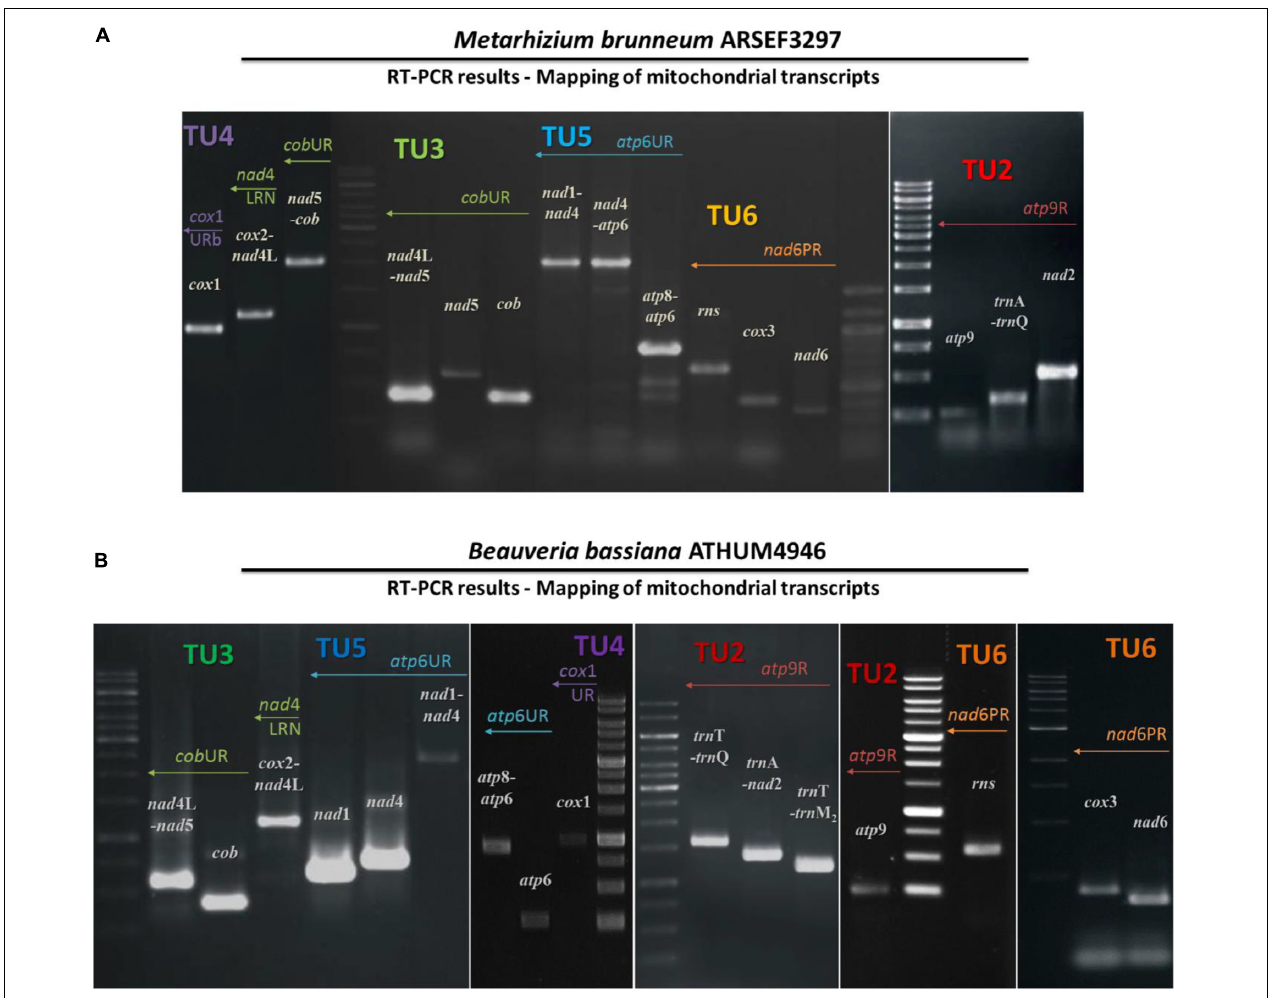
FIGURE 3 | The amplicons of mitochondrial primary transcripts as obtained by RT-PCR followed by PCR in the entomopathogenic fungi M. brunneum ARSEF3297 (A) and B. bassiana ATHUM 4946 (B) . The actual amplicons obtained. Ladder 1kb (GeneRuler 1 kb DNA Ladder, Thermo Fisher Scientific Inc, Waltham, MA) was used as marker. TU, transcription